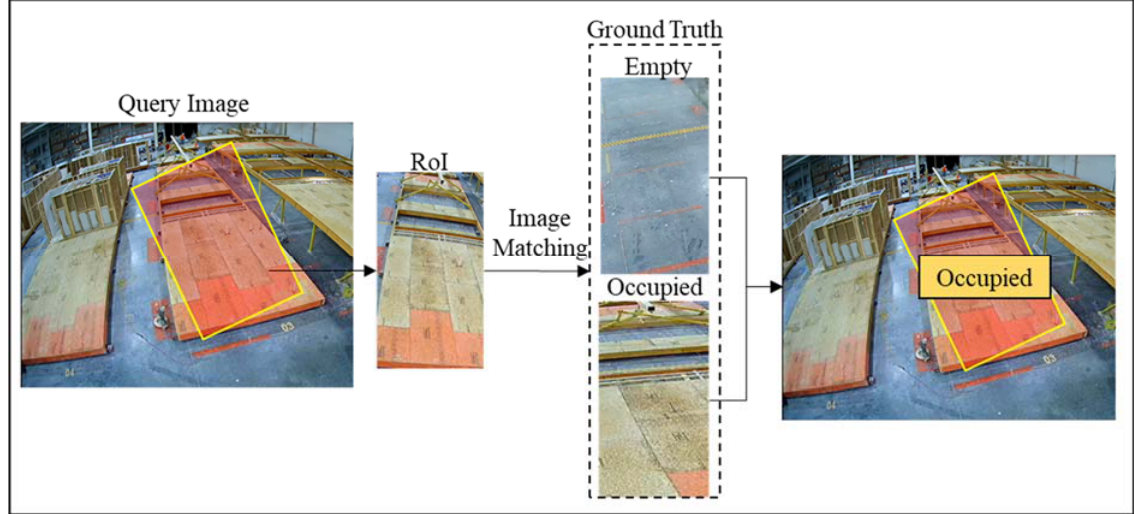
Figure 14. Overview of the image matching pipeline applied on a sample video frame.